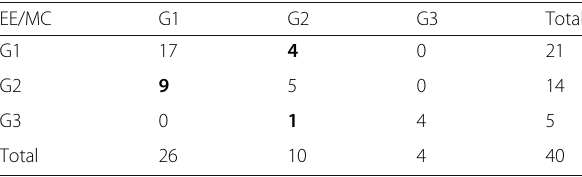
Table 2 Distribution by proliferative grade according to eyeball estimation (EE) and manual count